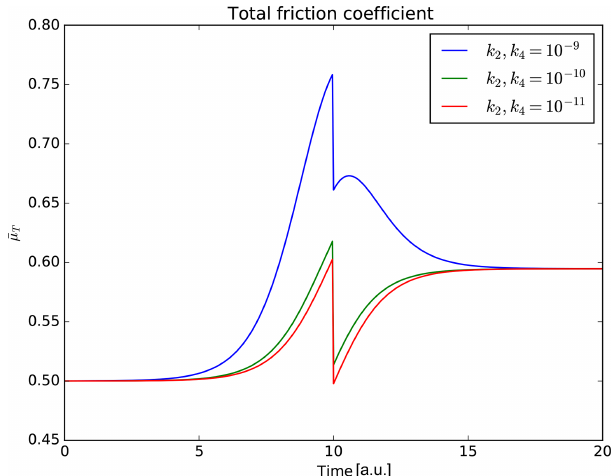
Figure 5. Total fiction coefficient from the seismo-electromagnetic theory derivation. If we consider one point within the rupture area, the highest values of friction are found before the earthquake ( t = 10a.u.). The friction decreases at t = 10a.u. was calculated using the stress drop as a function of the coseismic magnetic field. The maximum value is not completely recovered after the earthquake